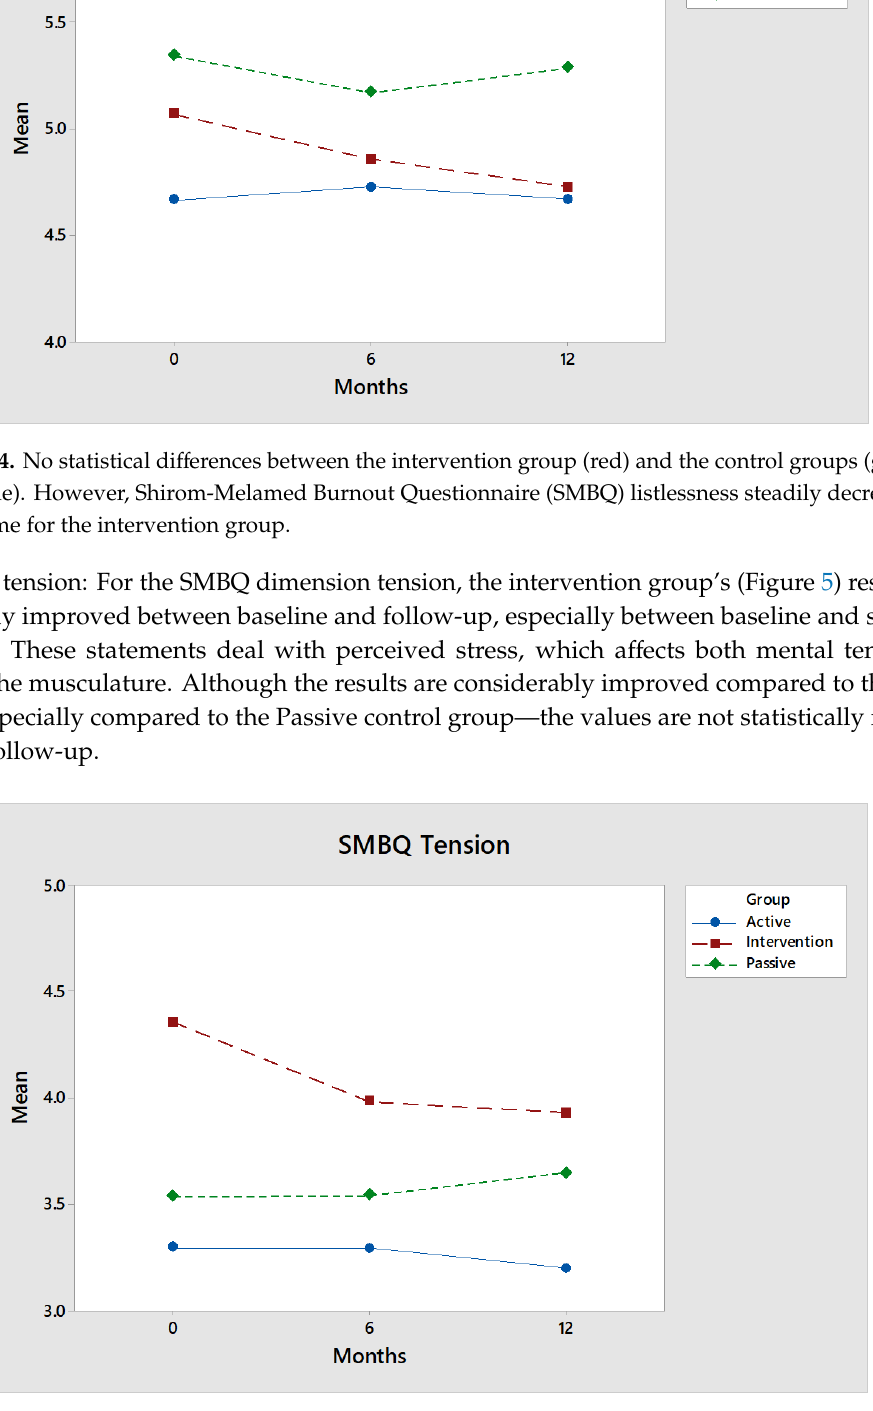
Figure 5. Values of the intervention group (red) improved over time, i.e., participants perceived less SMBQ tension at 12 months, measured by Hedges’ g, which is low, 0.18, for comparisons between the intervention group and the Active control group, but medium, 0.64, for comparisons between the intervention group and the Passive control group.